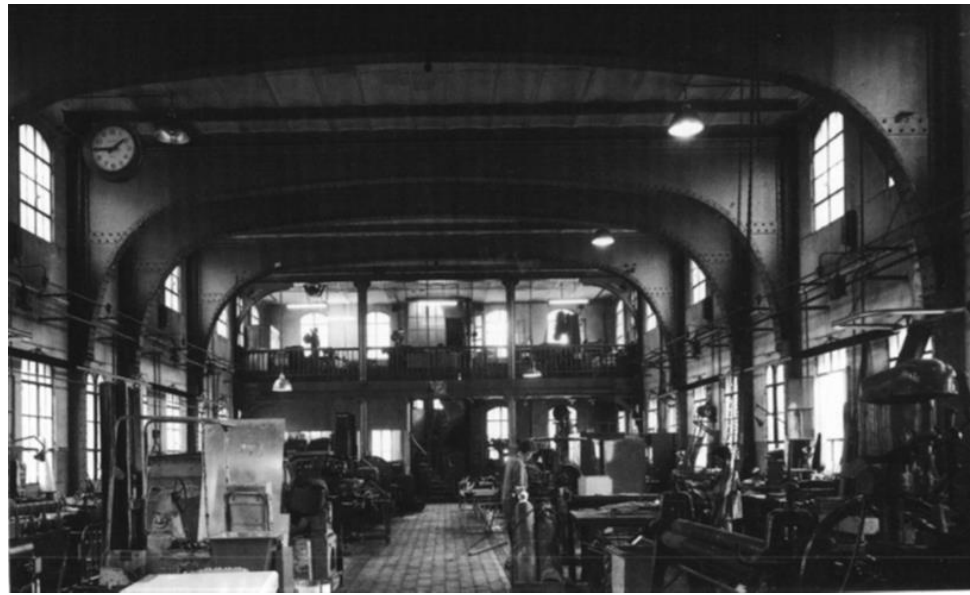
Figure 9. Menier Chocolate Factory, Photograph of the metal structure of the main room. Saulnier de- sign. Noisiel-sur-Marne, France in 1871–1872. Source: GA Document magazine. Modern Architecture: 1851–1919. Tokyo, 1981. Special issue nº 2. Edited by Kenneth Frampton for Ada